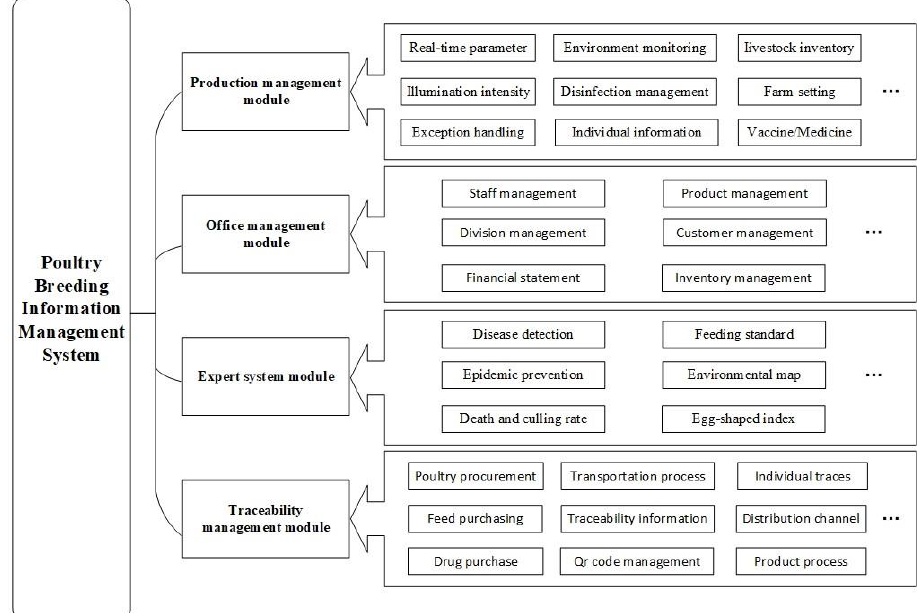
Figure 2. Functional framework of poultry farming information management system.